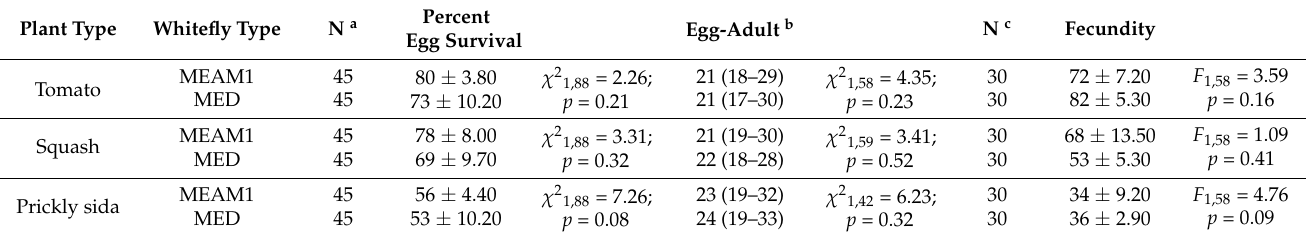
Table 3. Bemisia tabaci MEAM1 and B. tabaci MED life history parameters on tomato, squash, or prickly sida plants.